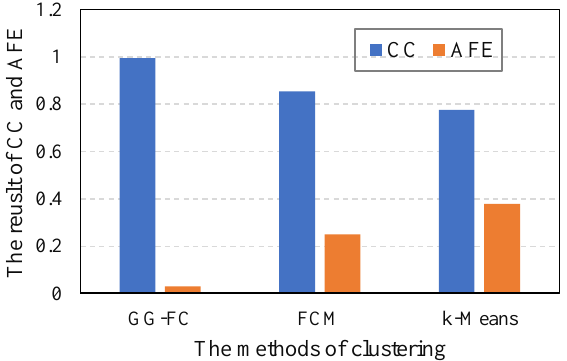
Figure 3. The results of CC and AFE in different